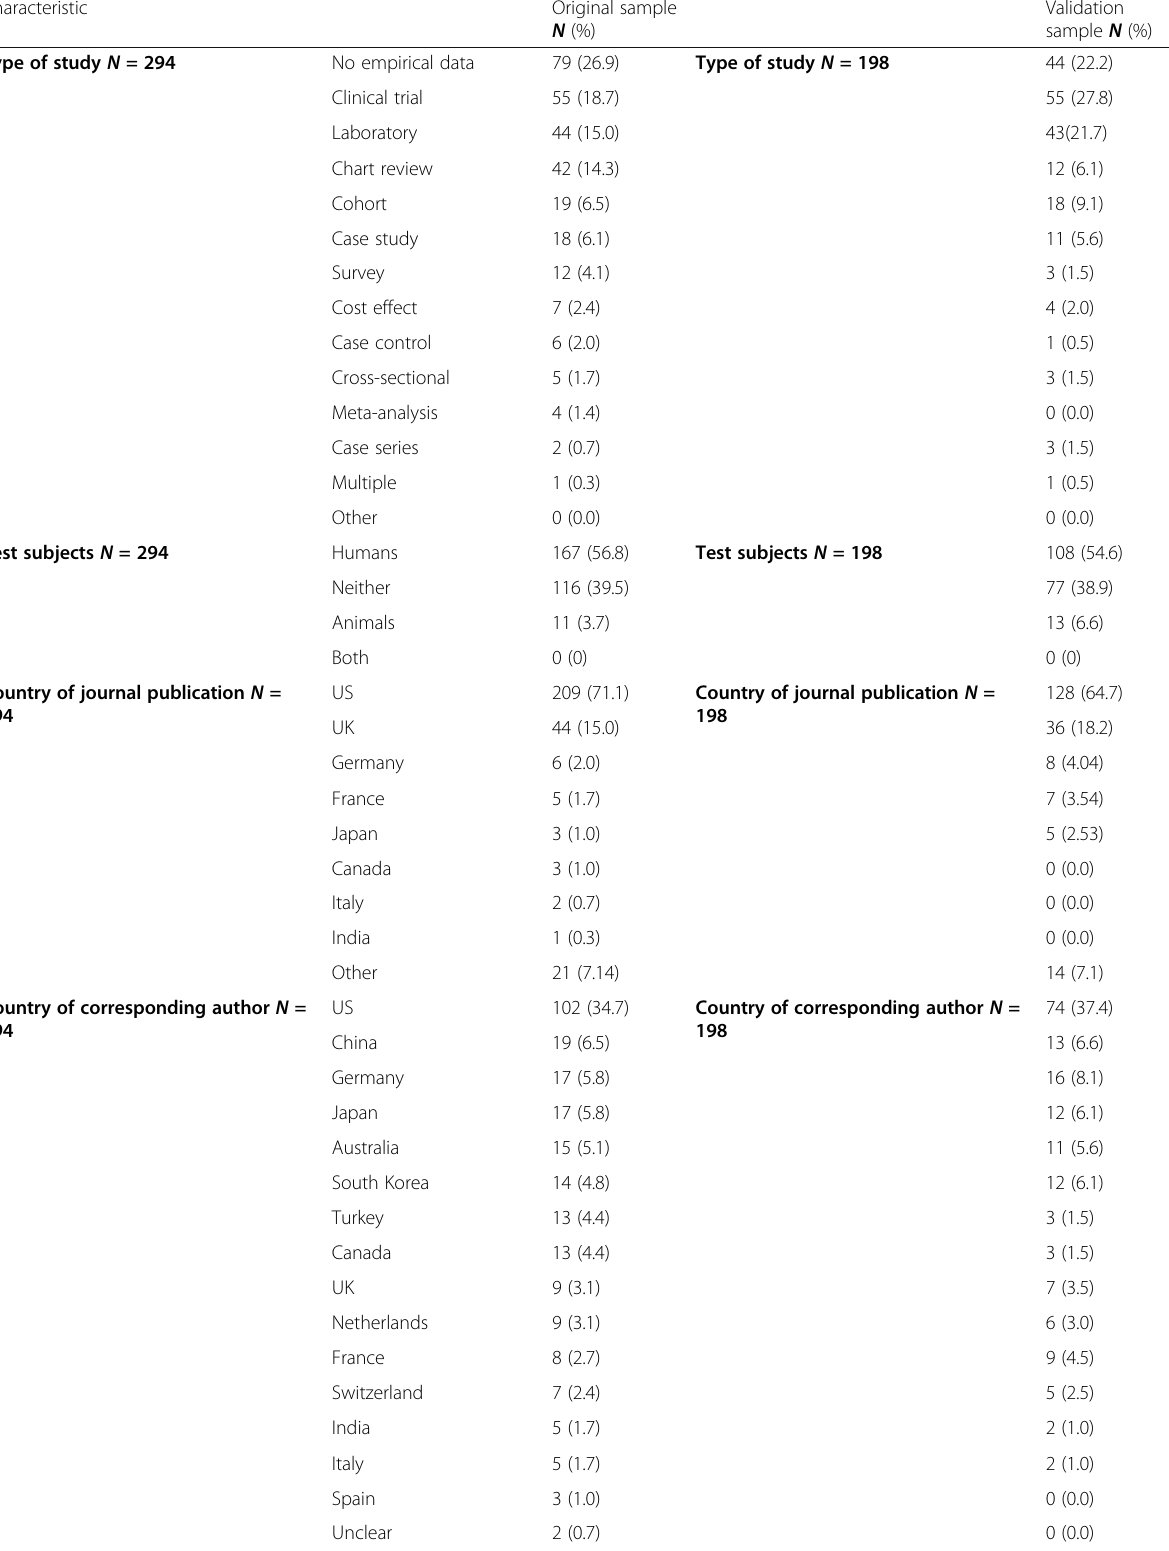
Table 2 Characteristics of included